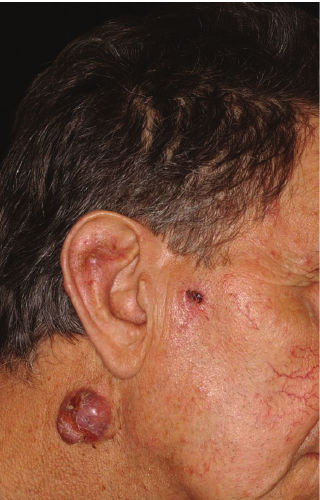
Figure 7: Case 5: A BCC on the right side of the neck and two smaller SCCs in the preauricular region and on the